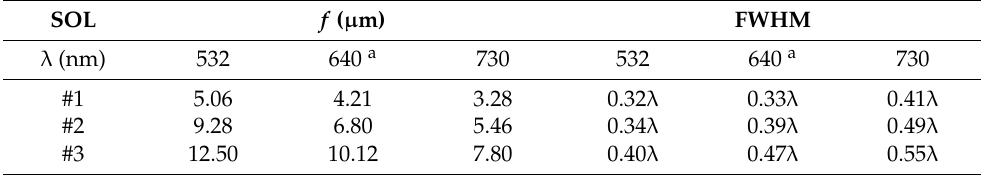
Table 3. The experimental dispersion features of the SOLs at three distinct wavelengths. SOL f ( µ m) FWHM λ (nm) 532 640 a 730 532 640 a 730 #1 5.06